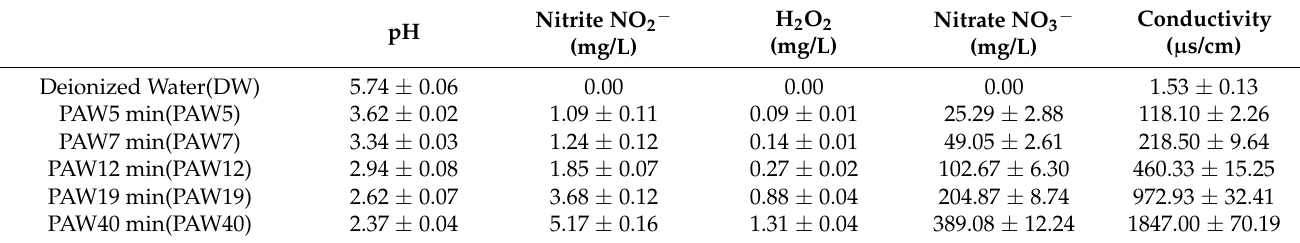
Figure 1. Optical emission spectrum of the surface dielectric barrier discharge (SDBD) with air from 200 to 600 nm. Table 1. Physicochemical properties of the plasma-activated water (PAW).